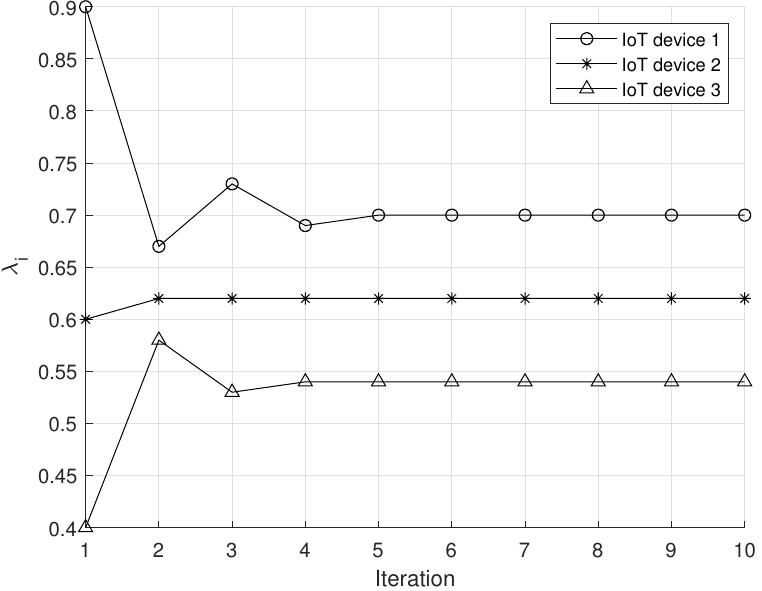
Figure 3. Convergence to the constrained Nash equilibrium policy.